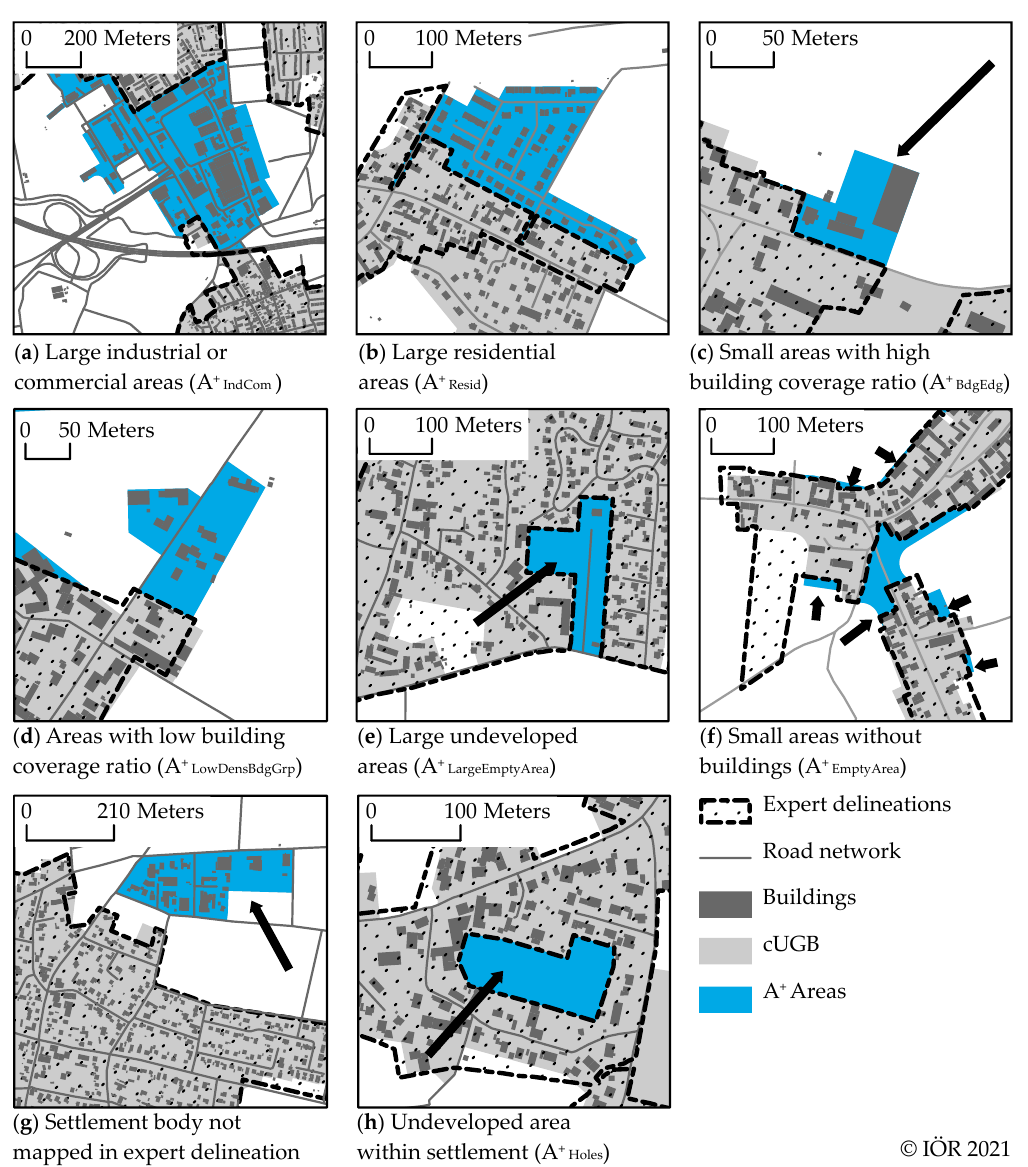
Figure 8. Types of area-positive deviations ( source : own compilation based on data from official building polygons, ATKIS ® Base-DLM © Geobasis-DE/BKG (2017), Planning Information System of the Joint State Planning Department